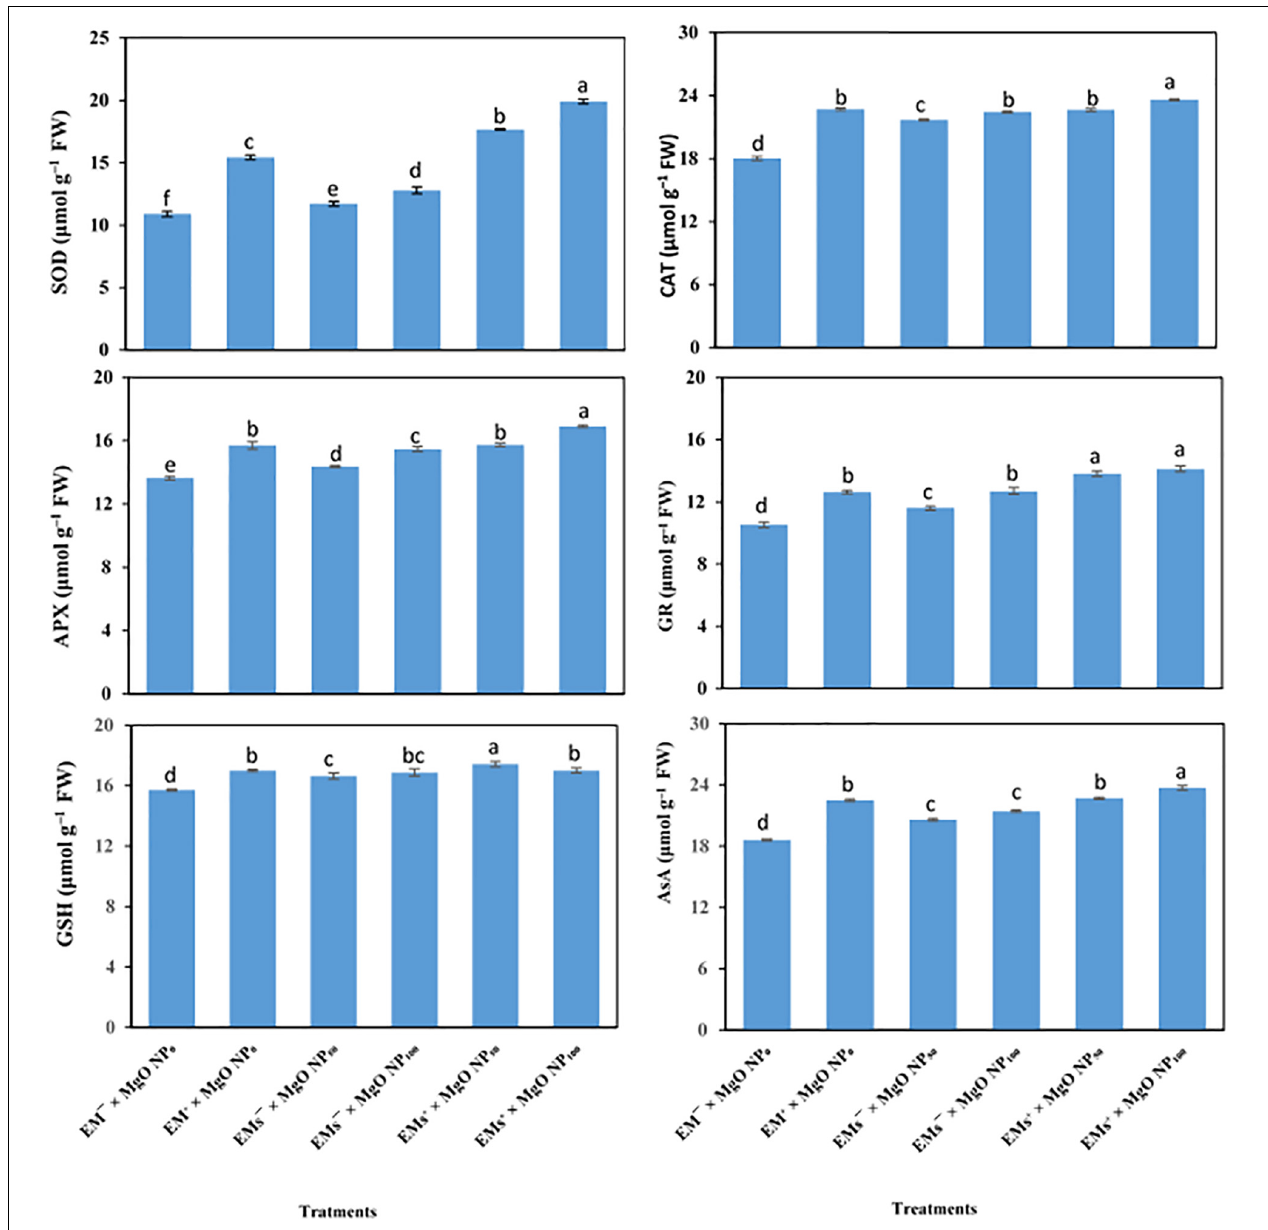
FIGURE 2 | Interactive effect of effective microorganisms (EMs) interacted with foliar application with magnesium oxide (MgO) nanoparticles (MgO-NP) on enzymatic [e.g., superoxide dismutase (SOD), catalase (CAT), ascorbate peroxidase (APX), glutathione reductase (GR), glutathione (GSH) and ascorbate (AsA)] antioxidants activity of sweet potato ( Ipomoea batatas L.) as average for both seasons. Different letters on the bars refer to significant differences among means based on Fisher’s least significant difference test at the p < 0.05